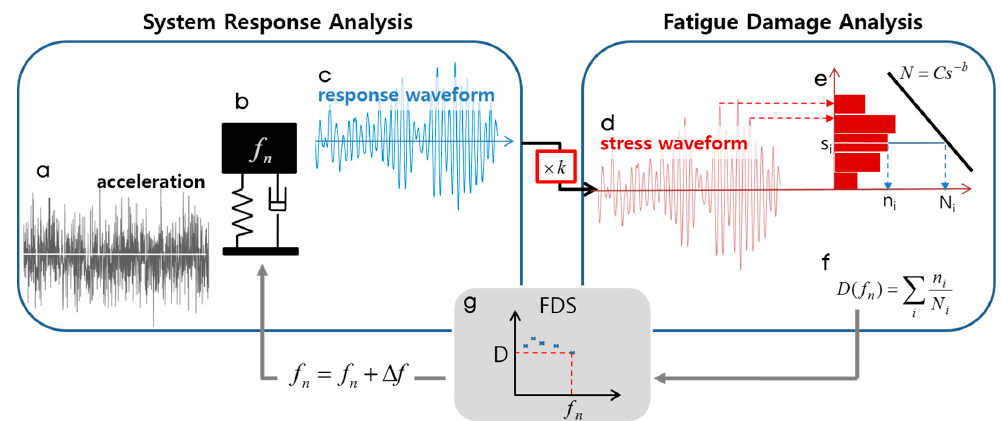
Figure 1. Flowchart of fatigue damage spectrum (FDS) calculations, ( a ) input acceleration, ( b ) Single Degree of Freedom (SDOF) system which is the virtual specimen, ( c ) velocity response, ( d ) stress waveform which is obtained by multiplying k to the velocity response, ( e ) stress counting and idealized stress–number (S-N) curve, ( f ) accumulation of damage index, ( g ) FDS.